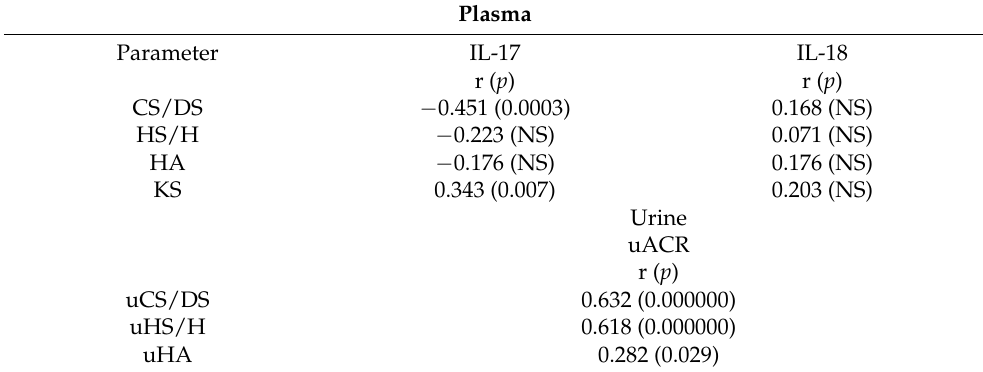
Table 3. Correlation analysis between plasma CS/DS, HS/H, HA, KS and IL-17 and IL-18 as well as urinary (u) CS/DS, HS/H, HA and uACR in patients with systemic sclerosis (Pearson’s correlation coefficients,